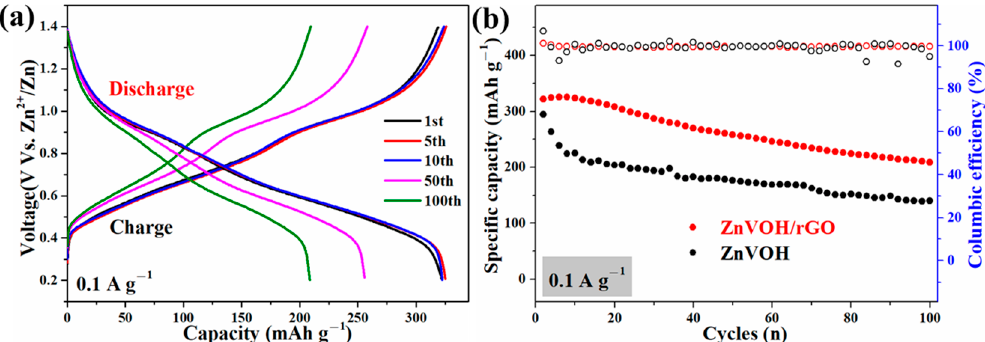
Figure 5. ( a ) GCD curves of ZnVOH and ZnVOH/rGO; ( b ) cycle performance of ZnVOH and ZnVOH/rGO at 0.1 A·g − 1 .